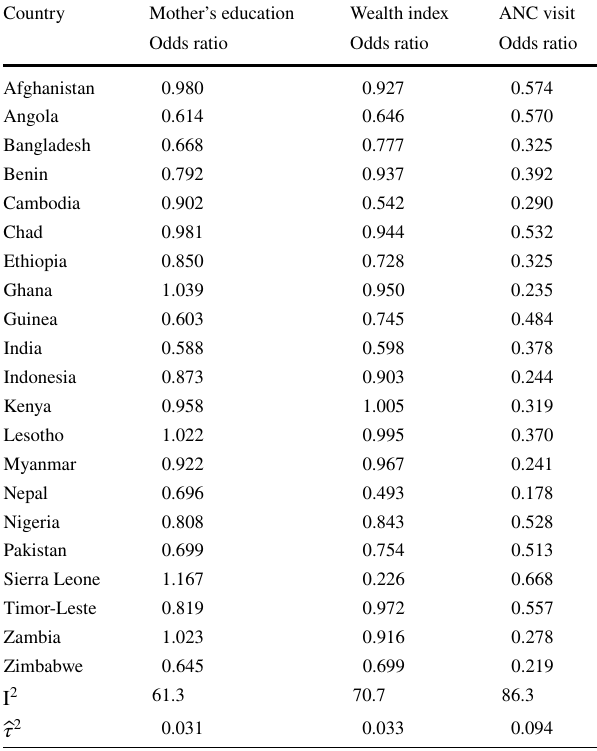
ANC antenatalcare , ̂𝜏 2 estimate of between-study variance.